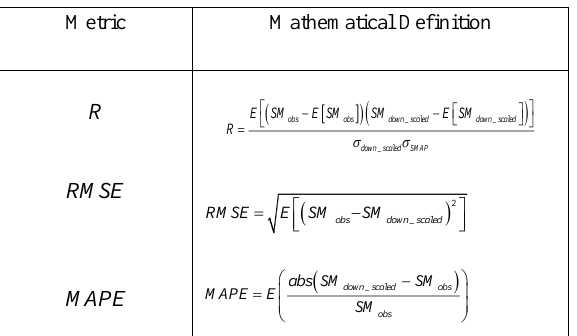
Table 1. Statitistical metric used between downscaled soil moisture and 1 km SMAP soil moisture product which has been already downscaled using Sentinel-1